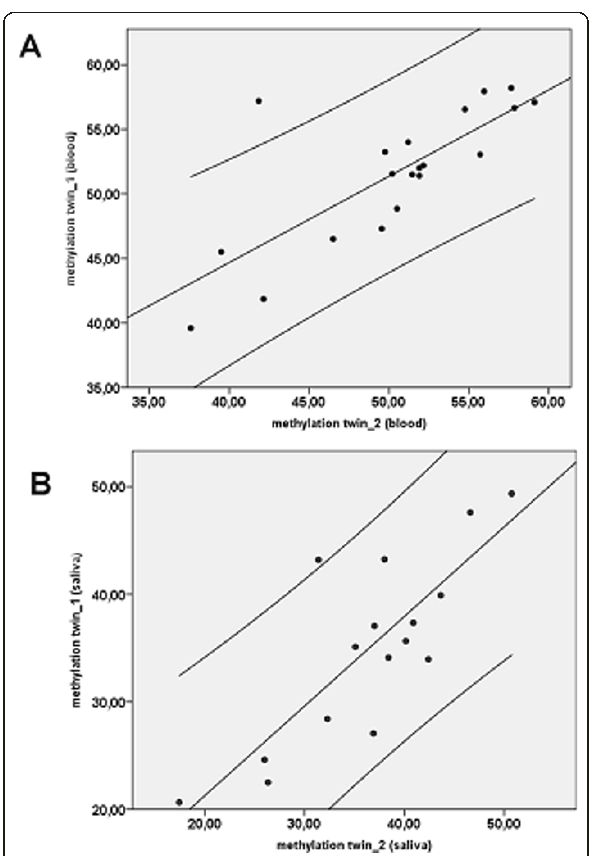
Figure 4 Intra-twinpair correlation between both twins for blood- (A) and saliva-derived DNA (B) . Note that in (B) one pair of outliers was not included in the